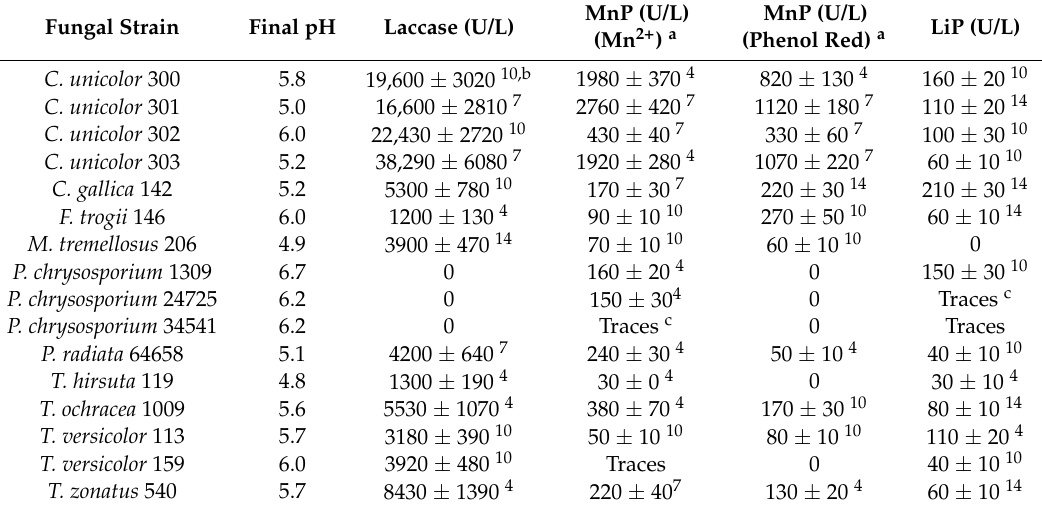
Table 2. Screening of WRB for LME production in the glycerol + mandarin peels-containing medium. Fungi were grown in shake flasks for 14 days at 27 ◦ C ( P. chrysosporium at 37 ◦ C); the nutrient medium contained 10 g/L glycerol and 20 g/L mandarin peels as carbon sources and 0.3 g/L veratryl alcohol as an enzyme synthesis